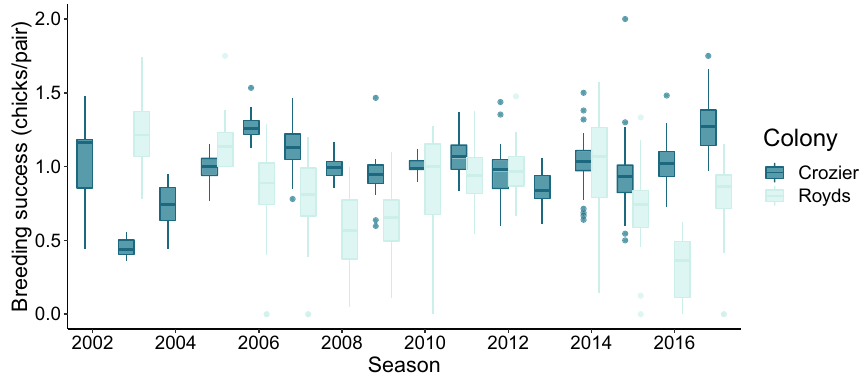
Figure 2. Boxplots showing annual reproductive success at Cape Crozier and Cape Royds, Ross Island, Antarctica, 2002–2017. Estimates are based on subcolony counts, the midline of the box is the median subcolony estimate with upper and lower hinges of the box representing the 25th and 75th percentiles and the whiskers extend from the hinges to the largest value no more than 1.5 times the distance between the hinges. Data beyond the ends of the whiskers are outlying points and plotted individually.